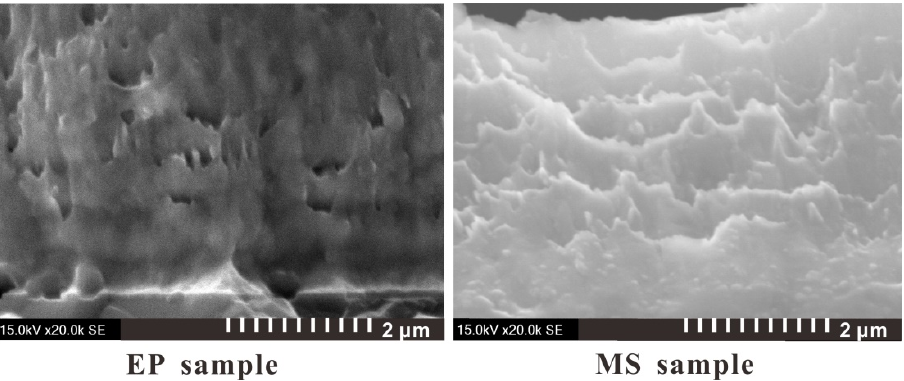
Figure 3. SEM diagram of the foil section of the multilayer bridge (side view, scale bar: 2 μm ).